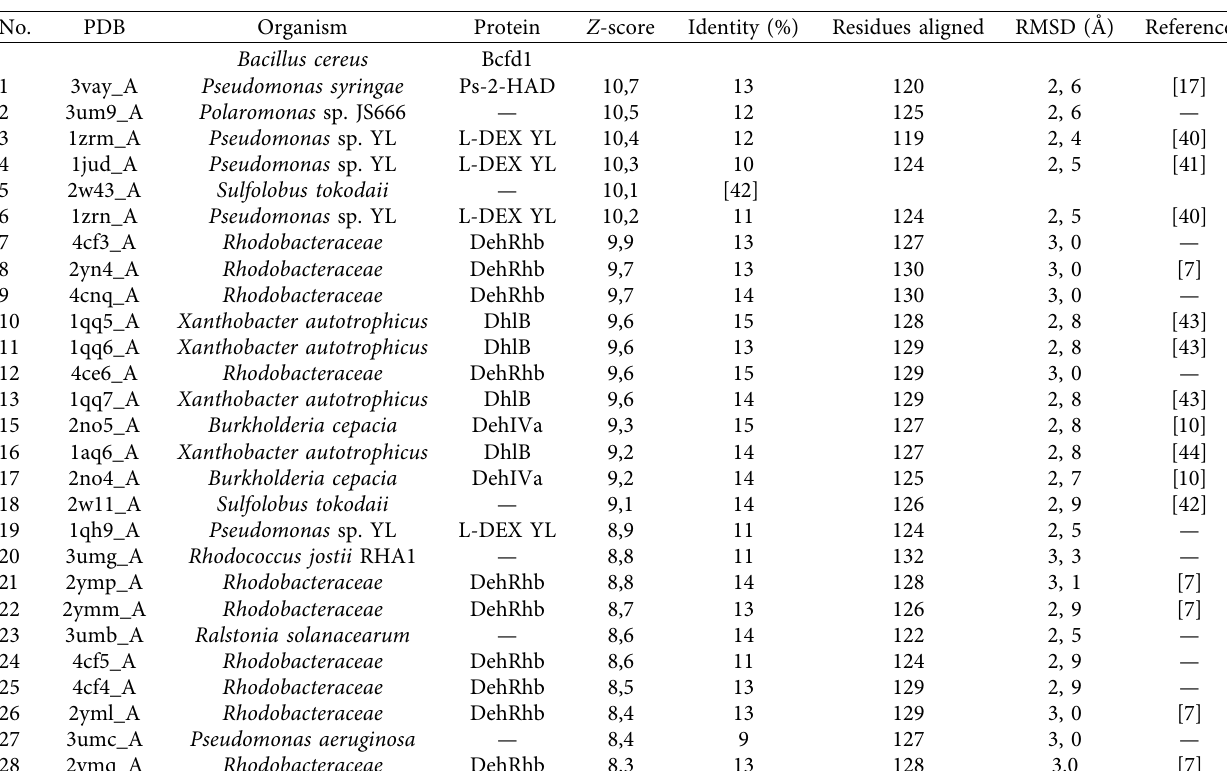
Table 4: The structure alignment results of Bcfd1 with the haloacid dehalogenases using the DALI